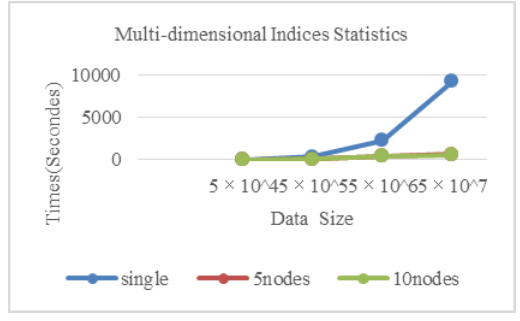
Figure 7. Computing time-consuming comparison